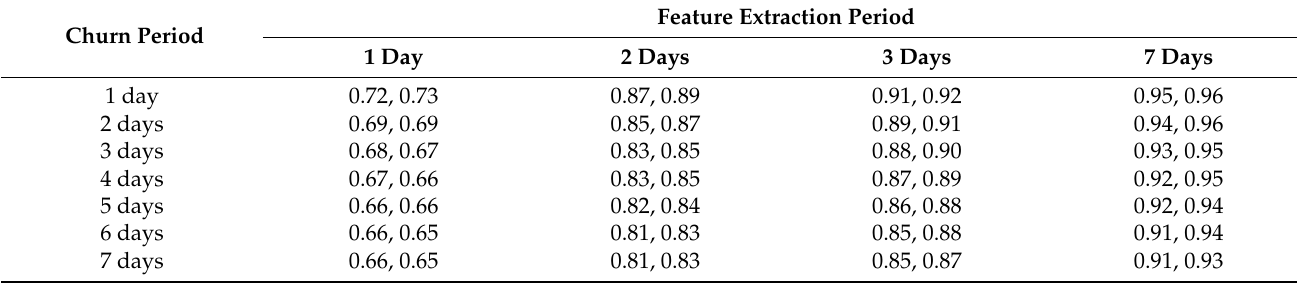
Table 2. Random forest classifier results—(accuracy, recall)